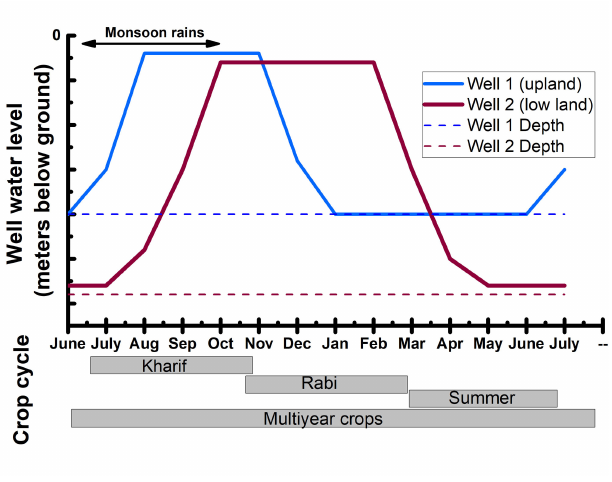
Fig. 2 . Stylized representation of groundwater and cropping cycle in field area. Groundwater level rises due to recharge from monsoon rainfall between June to October. In shallow aquifers, open-dug wells are the most common tools of extraction. Well recharge rate varies based on biophysical factors. This period corresponds to the Kharif (monsoon) crop. If there is a long dry spell in the season, wells may or may not have sufficient water to protect the crop. Postmonsoon Rabi (winter) and summer season crops require irrigation. Well levels start to drop because of groundwater extraction and partly because of subsurface flows. Farmers may transfer water between multiple wells that they own through pipelines to increase months of irrigation access, e.g., combine water from well 1 and well 2. Well levels are low in summer and summer crop is cultivable only in a few groundwater rich pockets. Poor rainfall or excessive extraction lead to long periods of dry wells until monsoon arrives again in the following